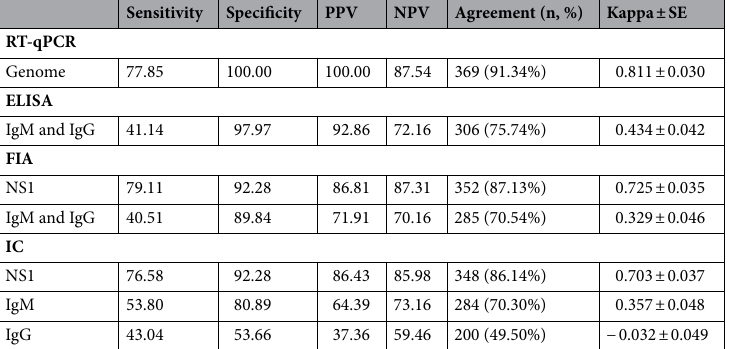
Table 2. Sensitivity, specificity, PPV and NPV of FIA and IC to detect NS1, IgM and IgG compared with the confirmed cases. PPV positive predictive value, NPV negative predictive value. The value of kappa index was interpreted according to the following scale; < 0: poor agreement, 0–0.2: slight agreement, 0.21–0.40: fair agreement, 0.41–0.60: moderate agreement, 0.61–0.80: substantial agreement, 0.81–1.00: perfect